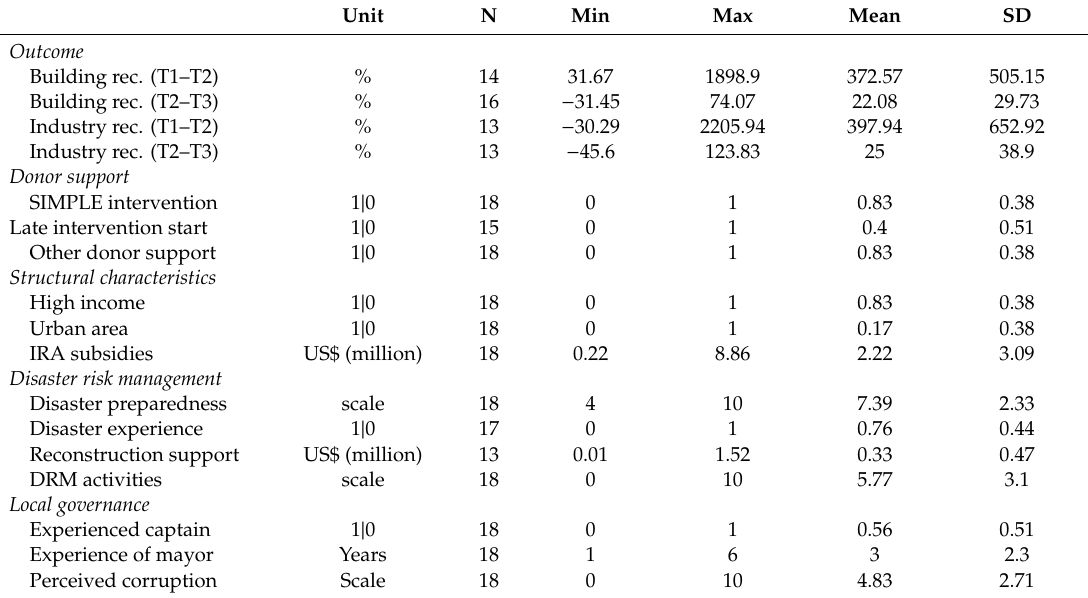
Table 3. Summary statistics of the analytical